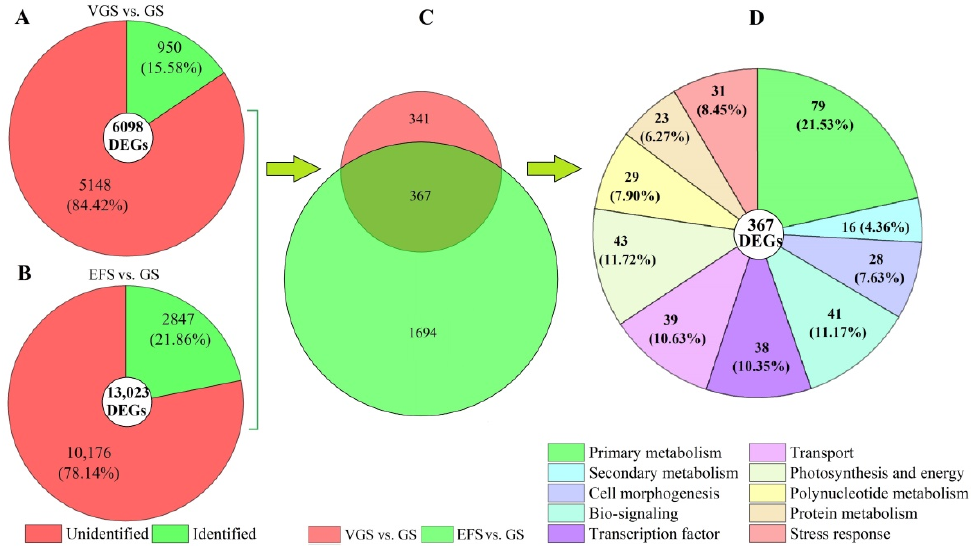
Figure 5. Distribution and classification of DEGs at VGS and EFS vs. GS. Images ( A , B ) represent the DEGs at VGS and EFS vs. GS, respectively; image ( C ) represents the co-expressed genes; image ( D ) represents the classification of the co-expressed genes.